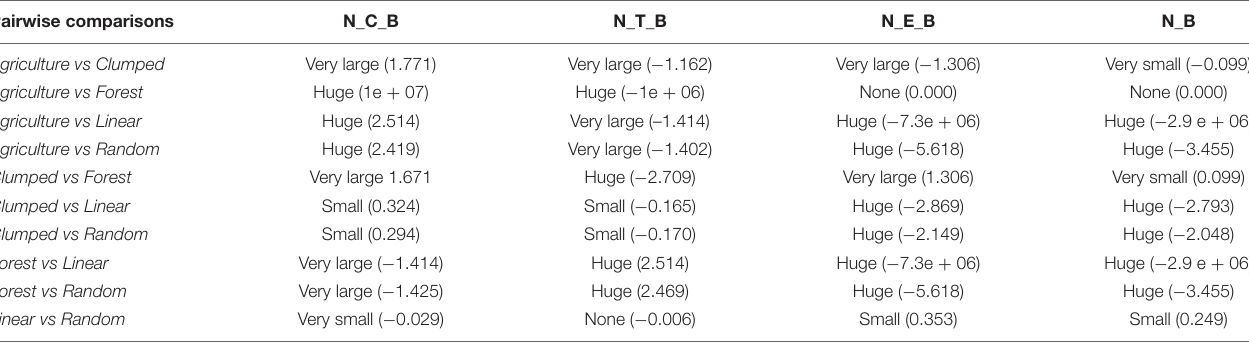
TABLE 2 | Pairwise comparisons (Cohen’s d) for the Normalized diversity predictions between all Agriculture landscapes (Agricultural landscapes details in Table 1 ): interpretation of Cohen’s d values and average d values in parenthesis. Positive values indicate higher diversity for the first landscape in comparison, negative values indicate higher diversity for the second landscape in comparison, and 0 indicates equivalent diversity values. N_C_B, normalized crop biodiversity; N_T_B, normalized tree biodiversity; N_E_B, normalized edge biodiversity; N_B, normalized biodiversity. Complementary Kruskal-Wallis and Stell-Dwass multiple comparisons test in Supplementary Appendixes 1–4